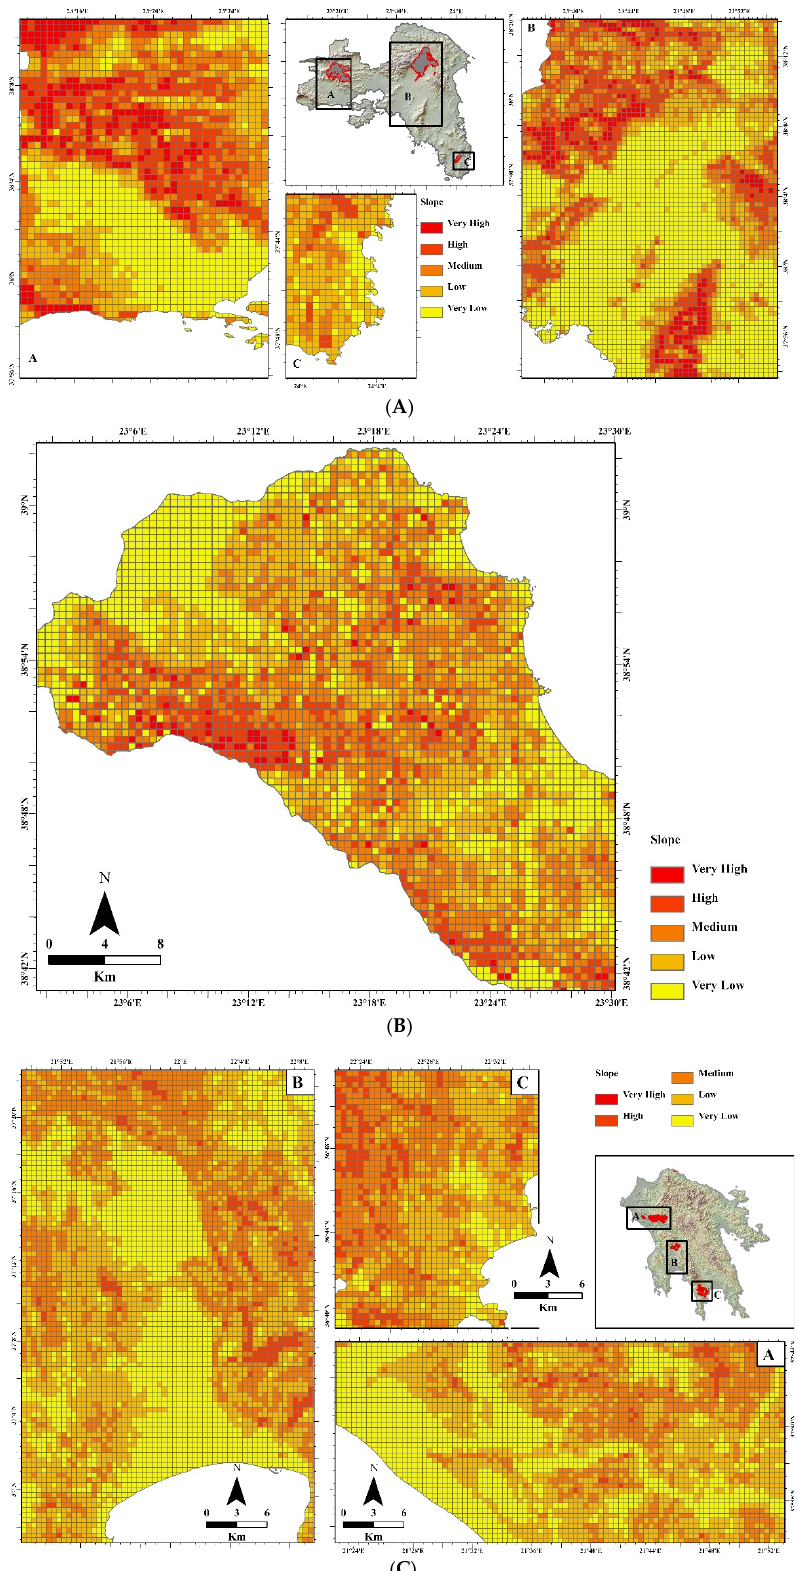
Figure 8. Classification of slope into five values: ( A ) Attica, ( B ) Euboea, and ( C ) Peloponnese.